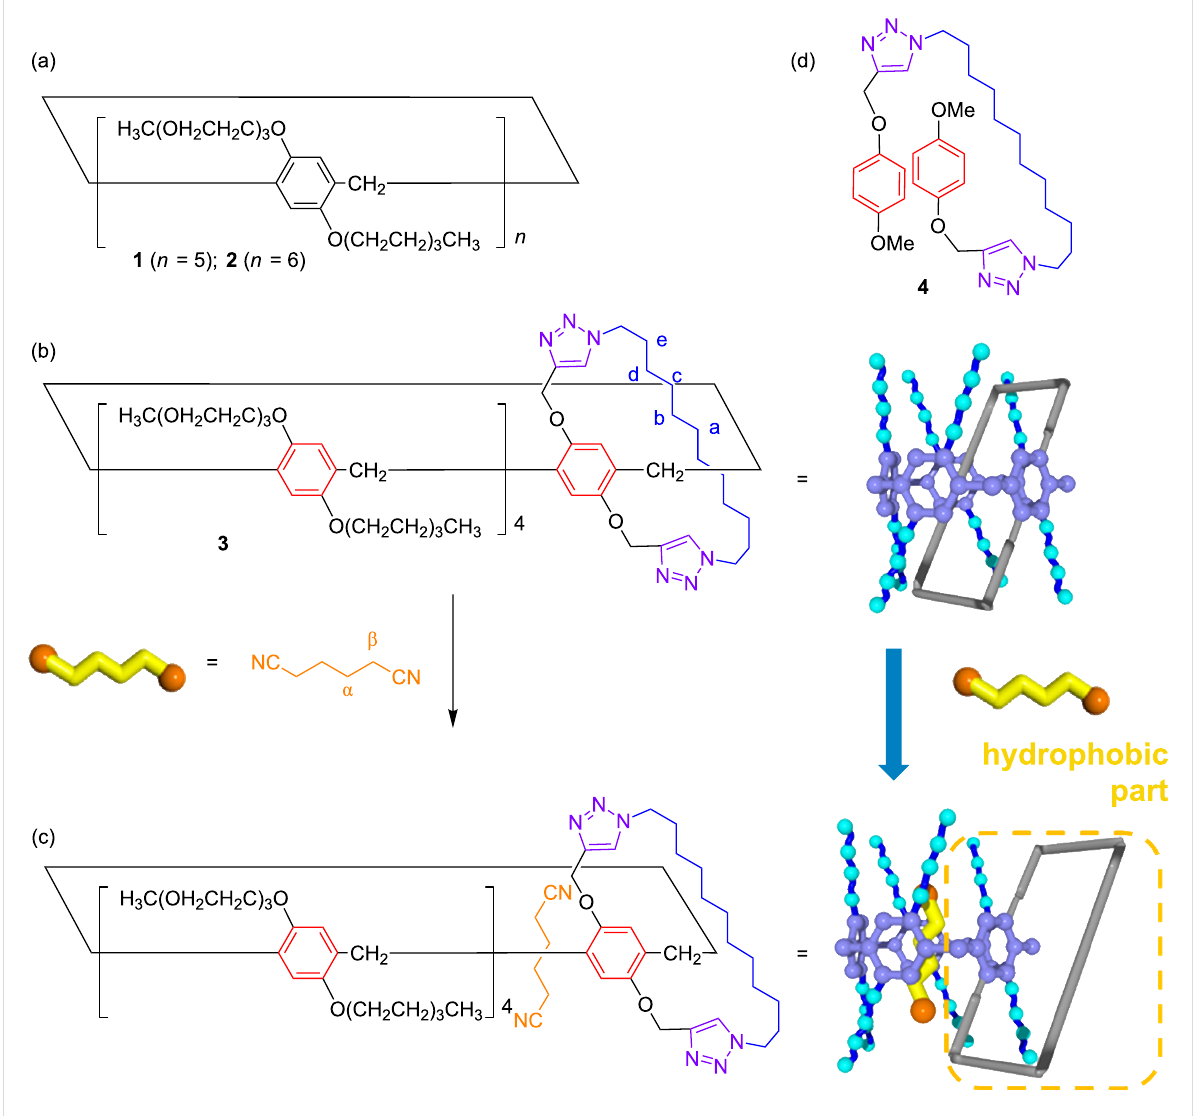
Figure 1: Chemical structures of (a) tri(ethylene oxide)-substituted pillar[ n ]arenes ( 1 , n = 5; 2 , n = 6), (b) pseudo [1]catenane 3 , (c) de-threaded form of 3 by complexation with 1,4-dicyanobutane, and (d) model compound 4 .